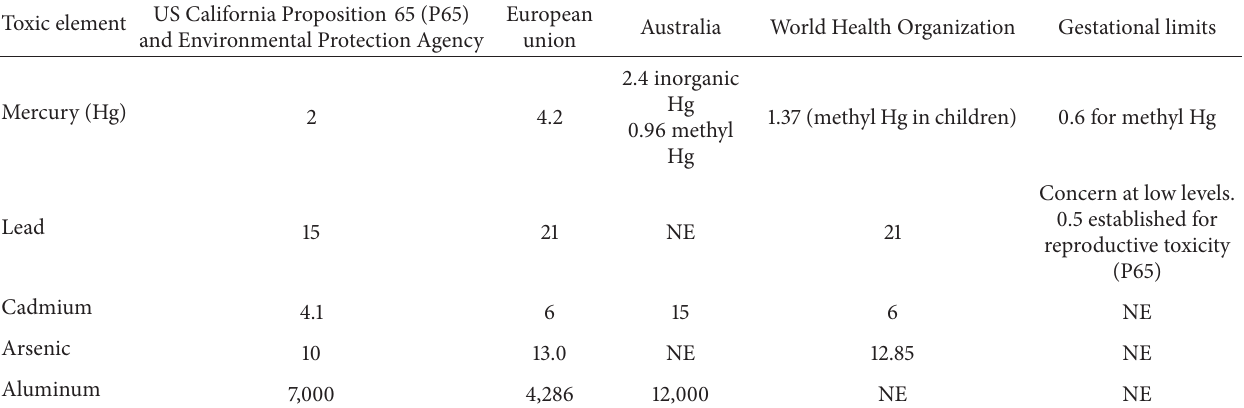
Table 2: Established toxicant limits in supplements ( 𝜇 gm/day) adapted from [51].